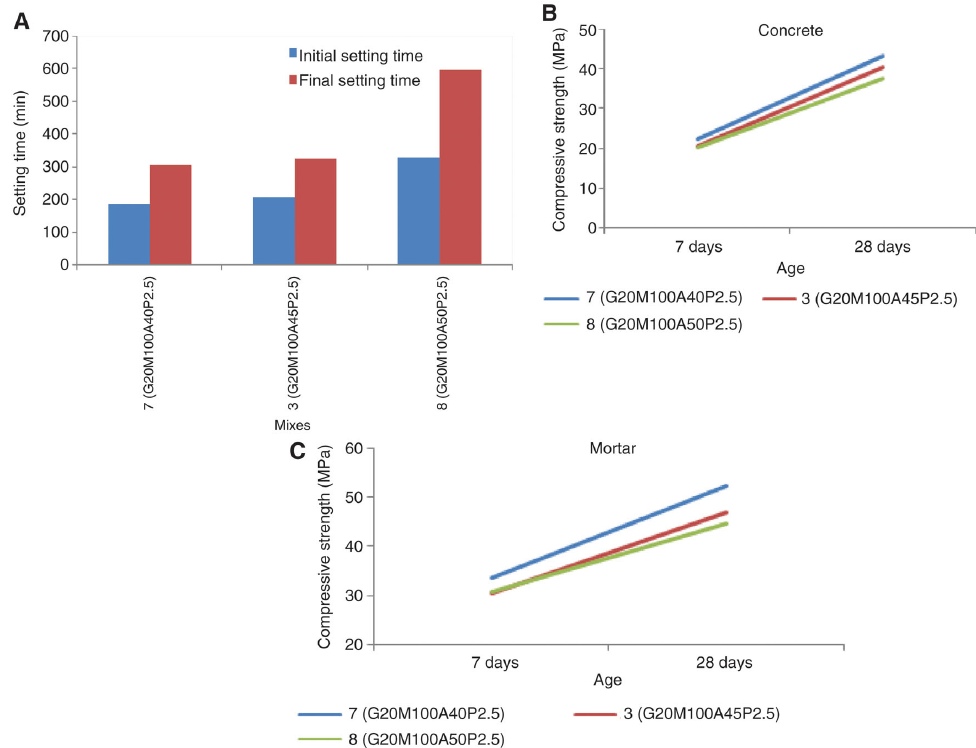
Figure 6: Effect of alkaline liquid on the setting time (A), compressive strength of geopolymer concrete and mortar (B) and